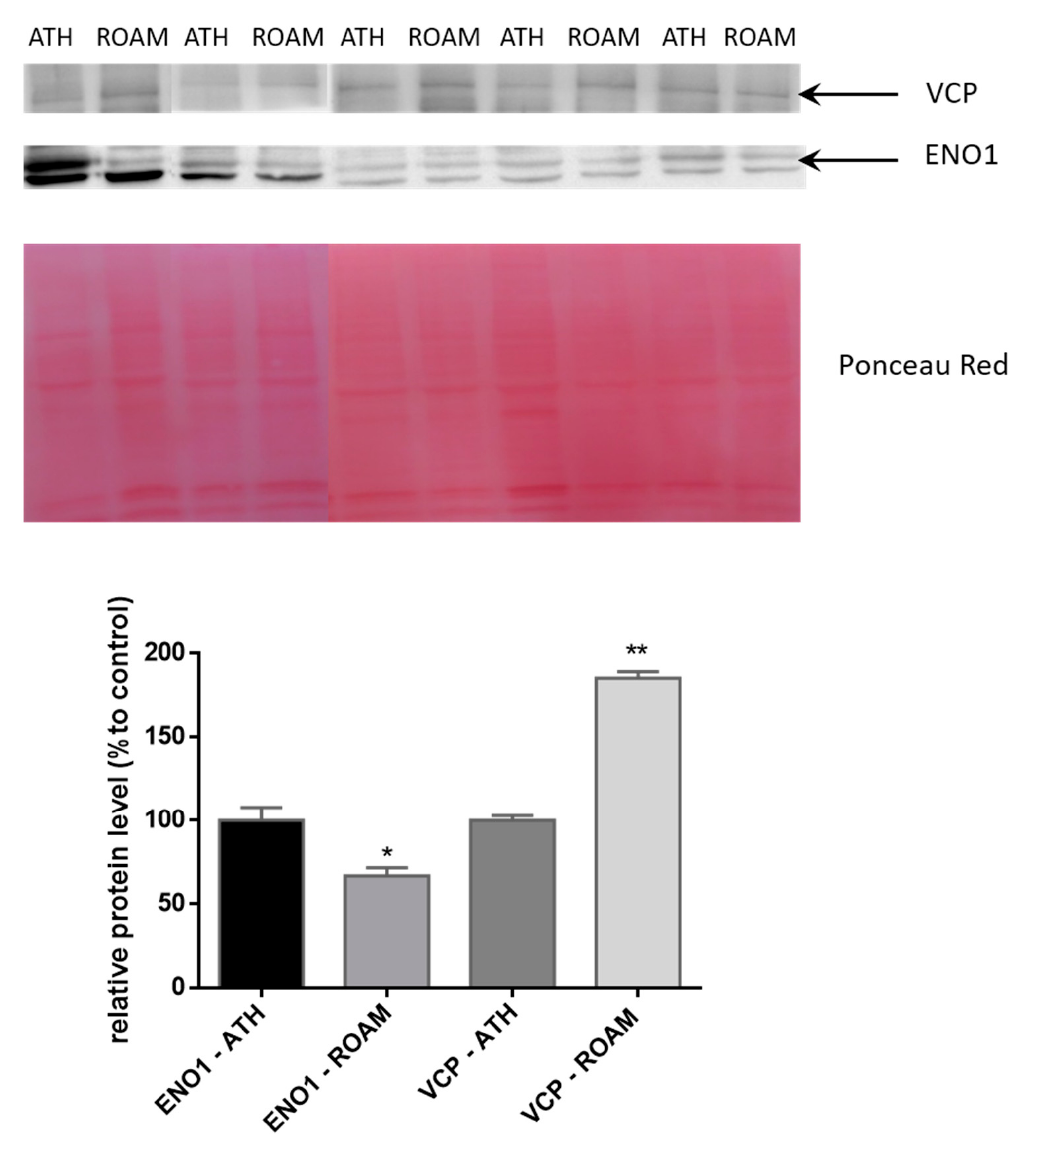
Figure 6. Representative Western blotting analysis of VCP and ENO1 in ATH and RAOM. The intensities of the immunostained bands were normalized with the protein intensities measured by Red Ponceau from the same blot. The bar graph shows the relative quantitation (band density) of VCP and ENO1 in ATH and RAOM. Results are shown as a histogram (* indicates p < 0.05, while ** indicates p < 0.01 statistical difference) and each bar represents mean ± standard error.